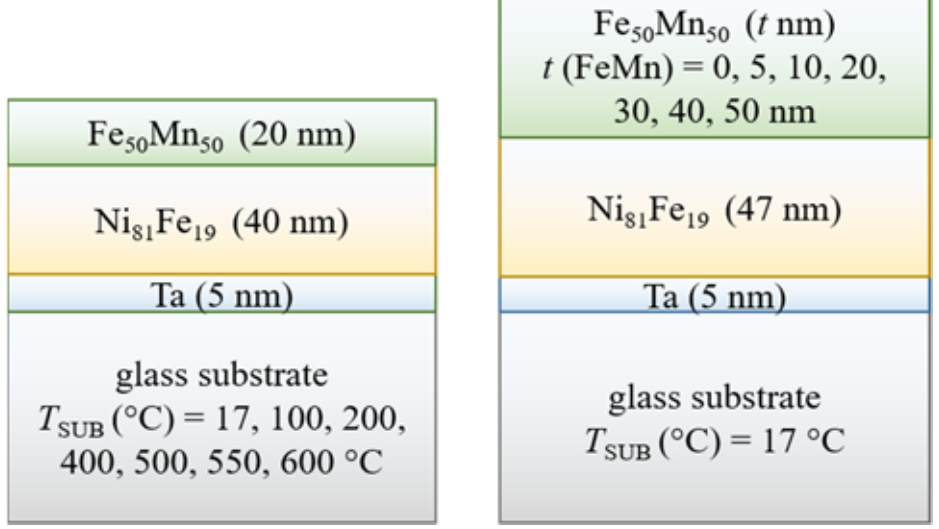
Figure 1. Schematic representation of the samples.